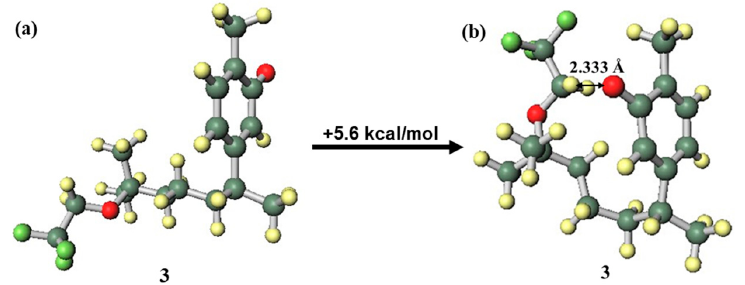
Figure 7. Difference in conformation stability of the compound 3 anion: ( a ) far conformation, ( b ) close conformation.